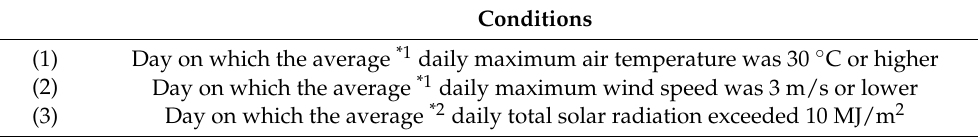
Table 2. Meteorological selection